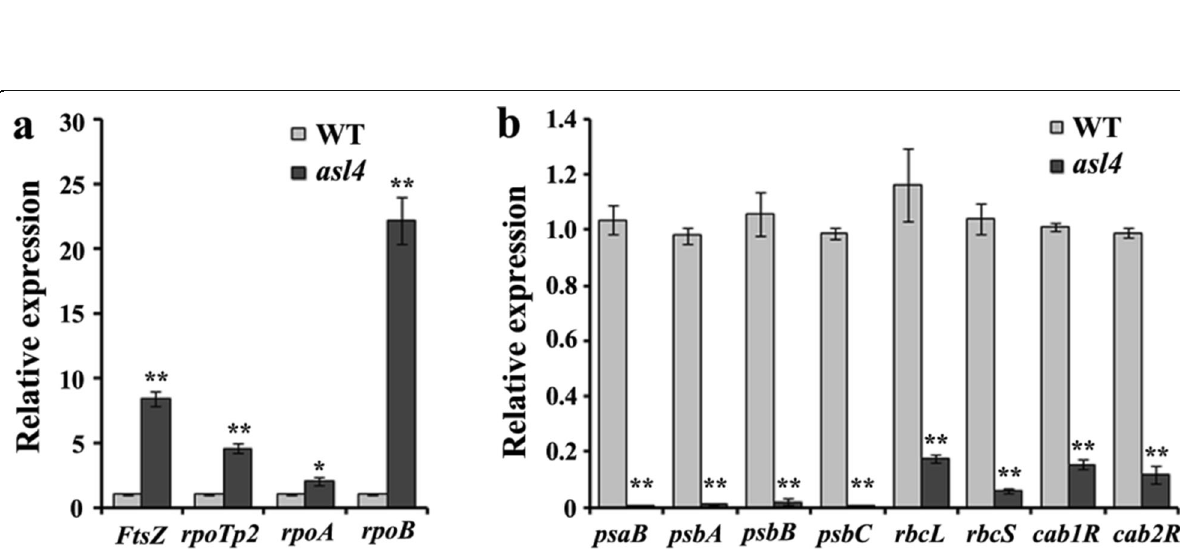
Fig. 6 Expression levels of genes involved in chloroplast biogenesis. Expression levels of genes associated with the first and second ( a ) and third ( b ) steps of chloroplast biogenesis in wild-type and asl4 mutant seedlings at the L3 stage. Data are means ± SD of three independent repeats. ** and *, indicate significance at P = 0.01 and P = 0.05, respectively, by Student ’ s t tests